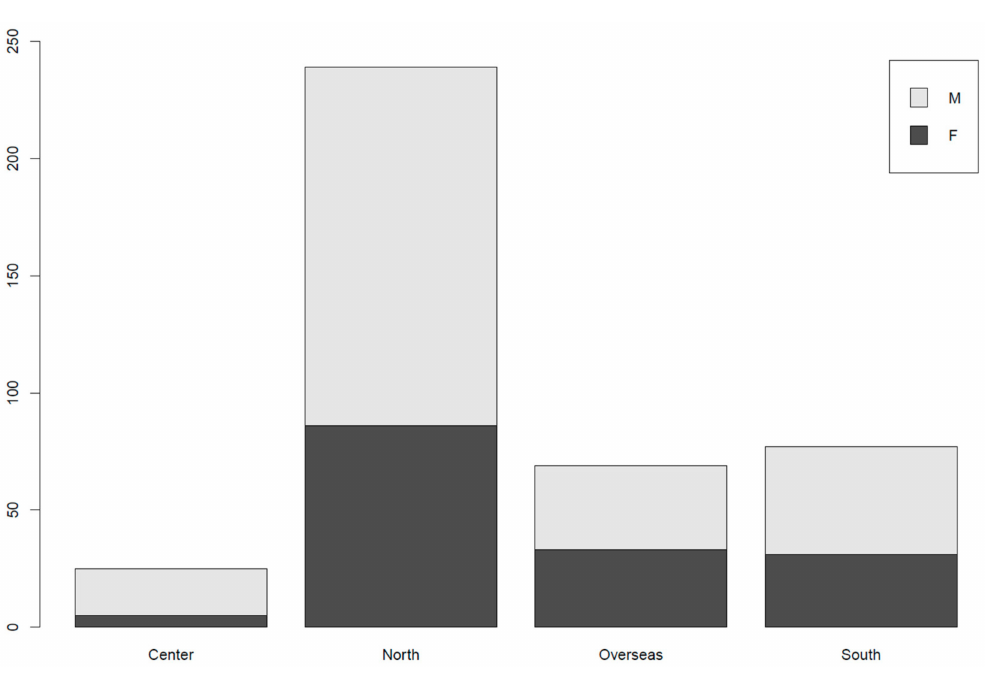
Figure 1. Regional and gender distribution of scientists.